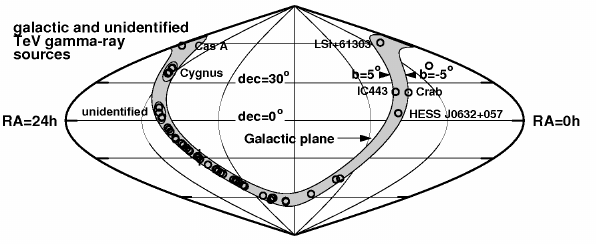
Figure 2: The vicinity of the Galactic plane and the galactic sources of TeV gamma rays in equatorial coor- dinates.